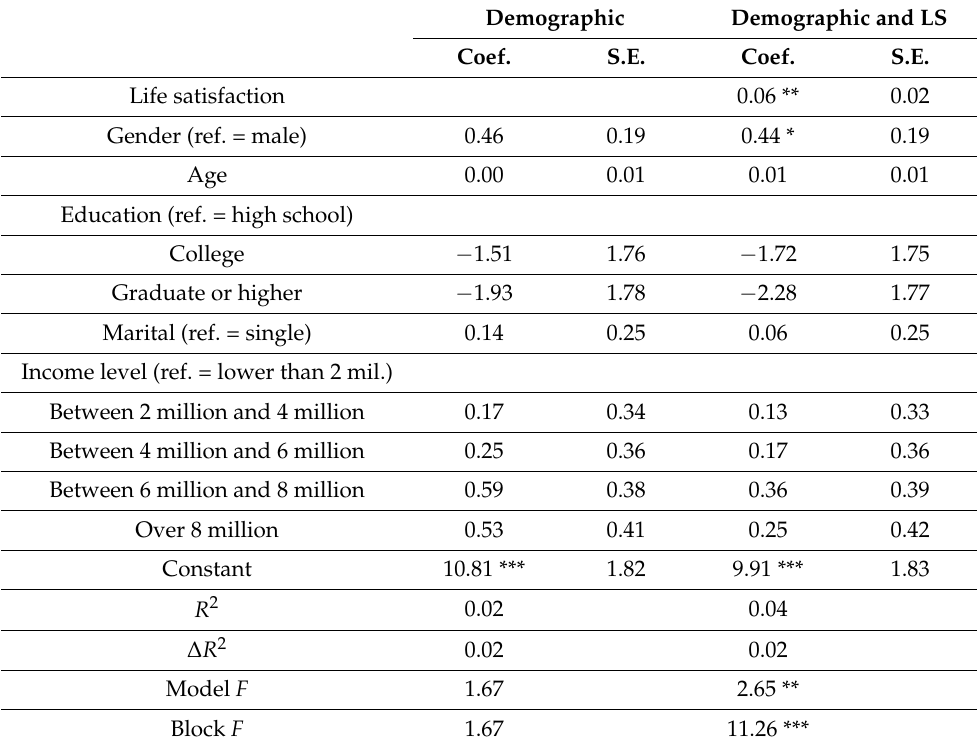
Table 2. Hierarchical linear modeling with nested regression ( n =